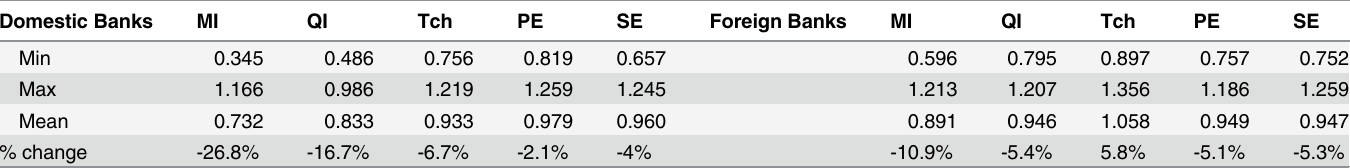
Table 6. Summary statistics of Malmquist index (MI).